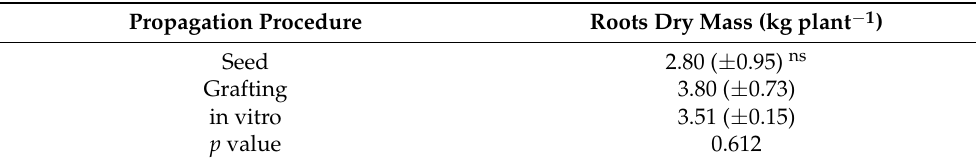
Figure 2. Roots density in ‘Alicia’ papaya propagated by seed (S), grafting (G), and in vitro (V) (average ± s.e.) in different soil depths (10–15; 25–30 and 40–45 cm) and distances from the trunk (0; 25 and 50 cm). Bars followed by different letters indicate statistically significant differences be- tween soil depths at each distance from the trunk. Table 1. Roots dry mass (average ± s.e.) in ‘Alicia’ papayas propagated by seed, grafting, and in vitro at the end of the experiment.